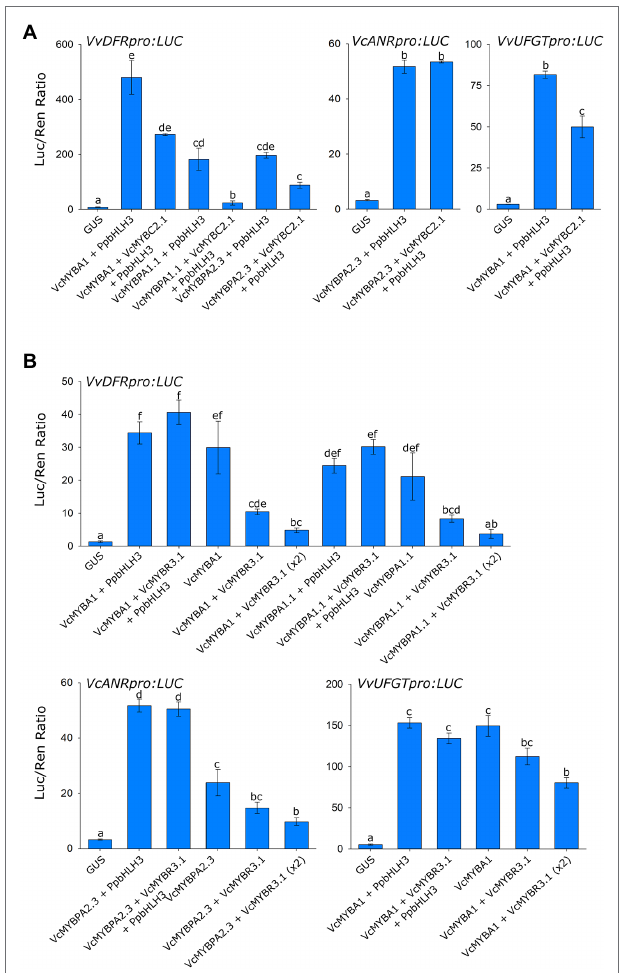
FIGURE 3 | VcMYBC2.1 and VcMYBR3.1 repress anthocyanin and proanthocyanidin biosynthetic gene expression. Promoter activation assays were performed in Nicotiana benthamiana leaves via Agrobacterium -mediated co-infiltration of MYB activators and PpbHLH3 , with and without either (A) VcMYBC2.1 or (B) VcMYBR3.1 , against the DFR , ANR and UFGT promoter:Luciferase constructs. GUS was used as a negative control. Values represent the mean of three biological replicates. Error bars show ± SEM. Letters indicate significant differences between treatments, assessed by one- way ANOVA and post hoc Tukey’s test ( P < 0.05) on log-transformed data.